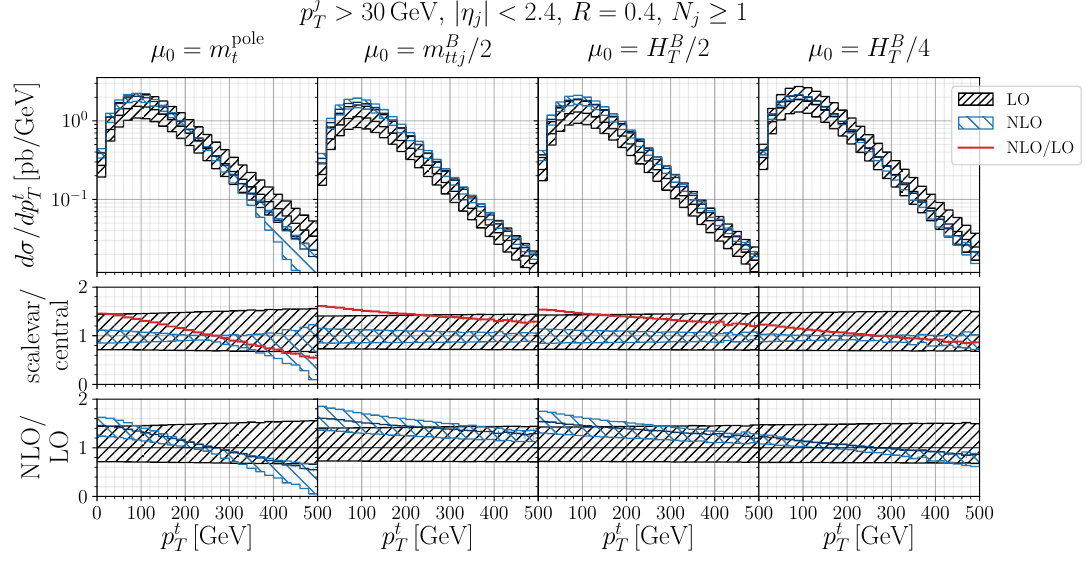
Figure 10 . Same as in figure 7, but for the p t